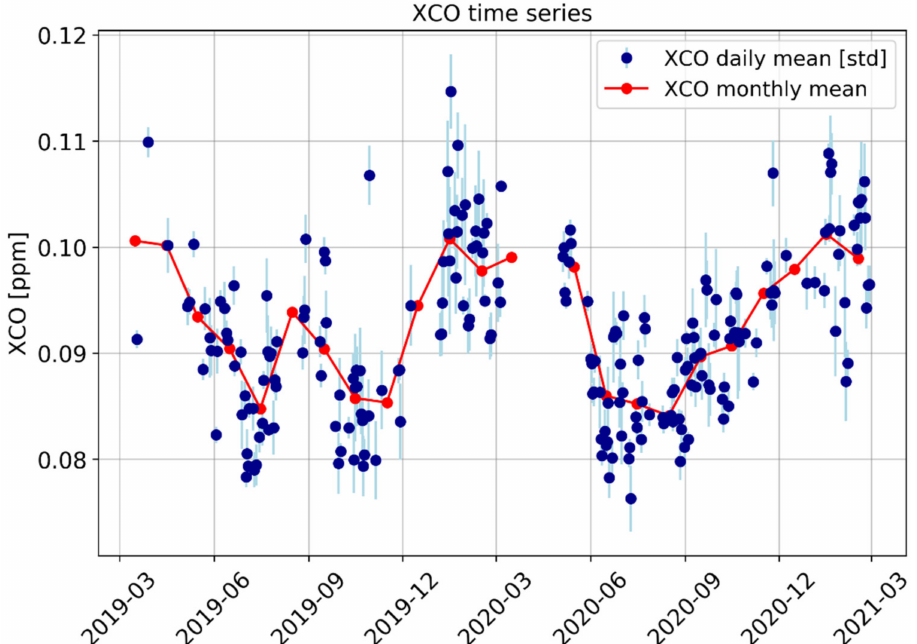
Figure 3. Dry-air mole fraction of carbon monoxide over Thessaloniki from March 2019 to February 2021. Daily mean and associated standard deviations are as blue dots and monthly means in red